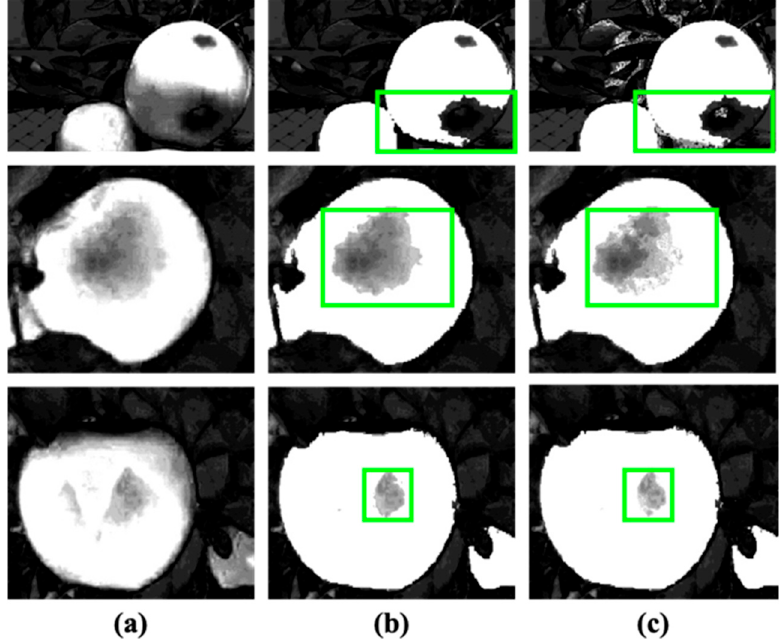
Figure 3. Comparison of the results of each stage in the fusion improvement saliency map. ( a ) saliency detection result; ( b ) saliency detection result merged with R-G result; ( c ) saliency detection result merged with R-G result and back projection result.